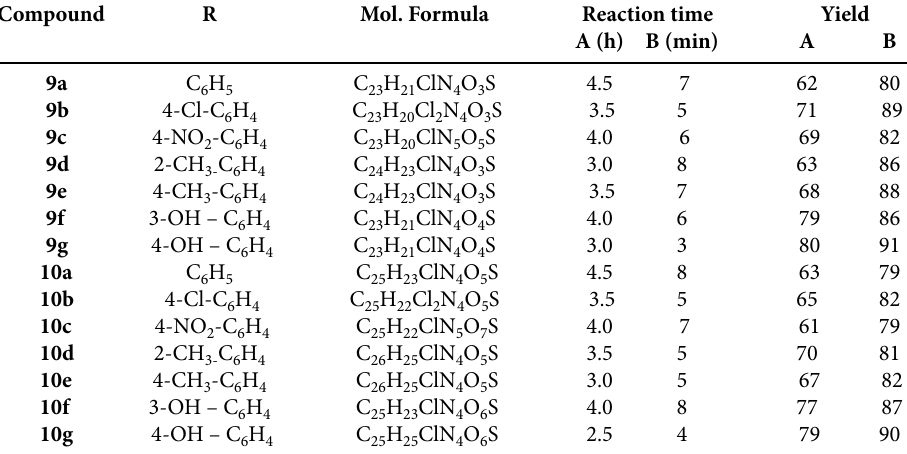
Table 1. Synthesis of compounds 9a–g and 10a–g Compound R Mol.